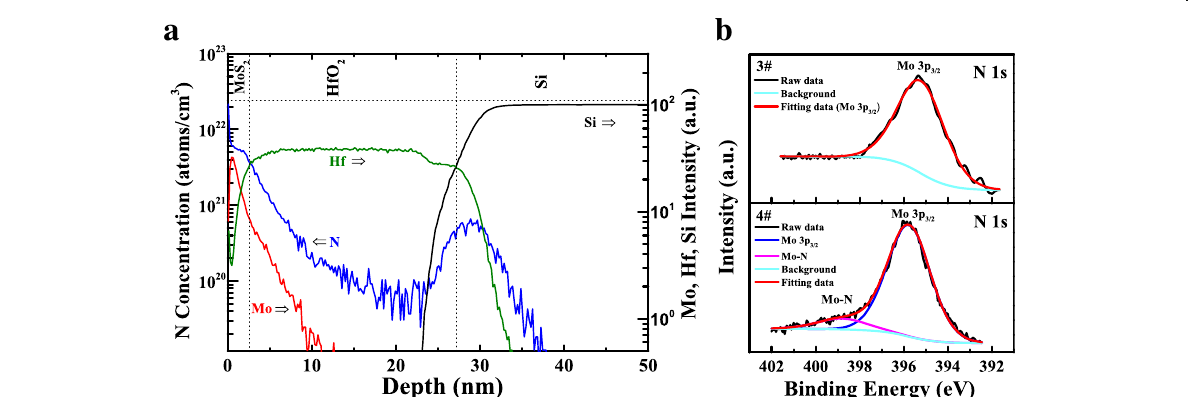
Fig. 2 a SIMS depth profiles of transferred MoS 2 film on nitrided HfO 2 /Si substrate. b N 1s XPS spectra for MoS 2 /HfO 2 heterojunctions with and without nitridation treatment,